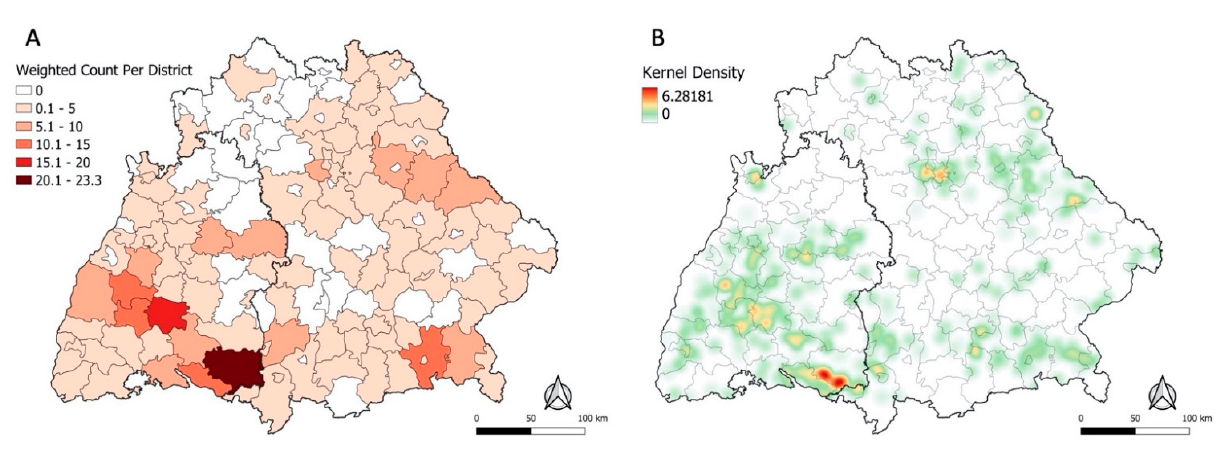
Figure 1. Sum of weighted self-reported POI per district from n = 359 cases from 2018–2020 ( A ). Heatmap of weighted self-reported POI from 2018–2020 with a bandwidth of 10 km ( B ). Temporal and spatial selection biases were investigated to examine the representa- tiveness of the study data as compared to the overall TBE infection pattern. Examination of the spatial distribution data did not raise concerns about bias, as the distribution of the study data was comparable to all notified TBE cases in the study area (Figure S2). 3.2. Spatial Clustering of Places of TBE Infection On visual inspection, the distribution of the POI appears spatially heterogeneous (Figure 1). Most places were reported in Baden-Wuerttemberg in the districts Ravensburg, Zollernalbkreis, Bodenseekreis, and Freudenstadt. In Bavaria, the districts with the high- est weighted count of places were Rosenheim, Schwandorf, and Unterallgaeu. Only few places were concentrated in the northern and central areas of the study region. Figure 1B displays the same data but unaggregated as a heatmap, revealing clear contrasts in the density of POI within the district. For instance, the heatmap for Ravensburg (darkest dis- trict in Figure 1A) showed POI only concentrated in the southern region of the district. 3.3. Individual Environmental Characteristics of Places of TBE Infection It is reasonable to assume that the specific suitability of TBE foci as tick habitats, as demonstrated by the observed presence of TBE virus-carrying ticks, may be reflected in distinctive environmental characteristics of these foci [29]. Therefore, characteristics of comparator points are expected to differ from those of foci, since comparator points were generated randomly. Knowledge of distinctive individual environmental characteristics may be informative for identifying new POI. Moreover, if environmental characteristics of POI were similar to those of the natural foci and different from comparator places, this may imply that the reliability of the POI is high. Selected abiotic covariates were thus compared between POI, TBE foci, and comparator places. The value ranges of multiple covariates differed considerably between the three types of places (Figure 2). Partly driven by the small sample size, the value range of TBE foci was the smallest for most covariates (interquartile range and general spread). The average number of “annual frost days”, “annual snow cover days”, and “mean summer temperature” barely differed between POI and comparator places. TBE foci had slightly more “frost days” and less “snow cover days” per year. Foci were on average 0.4 °C warmer during summer . None of the abiotic covariates showed strikingly similar